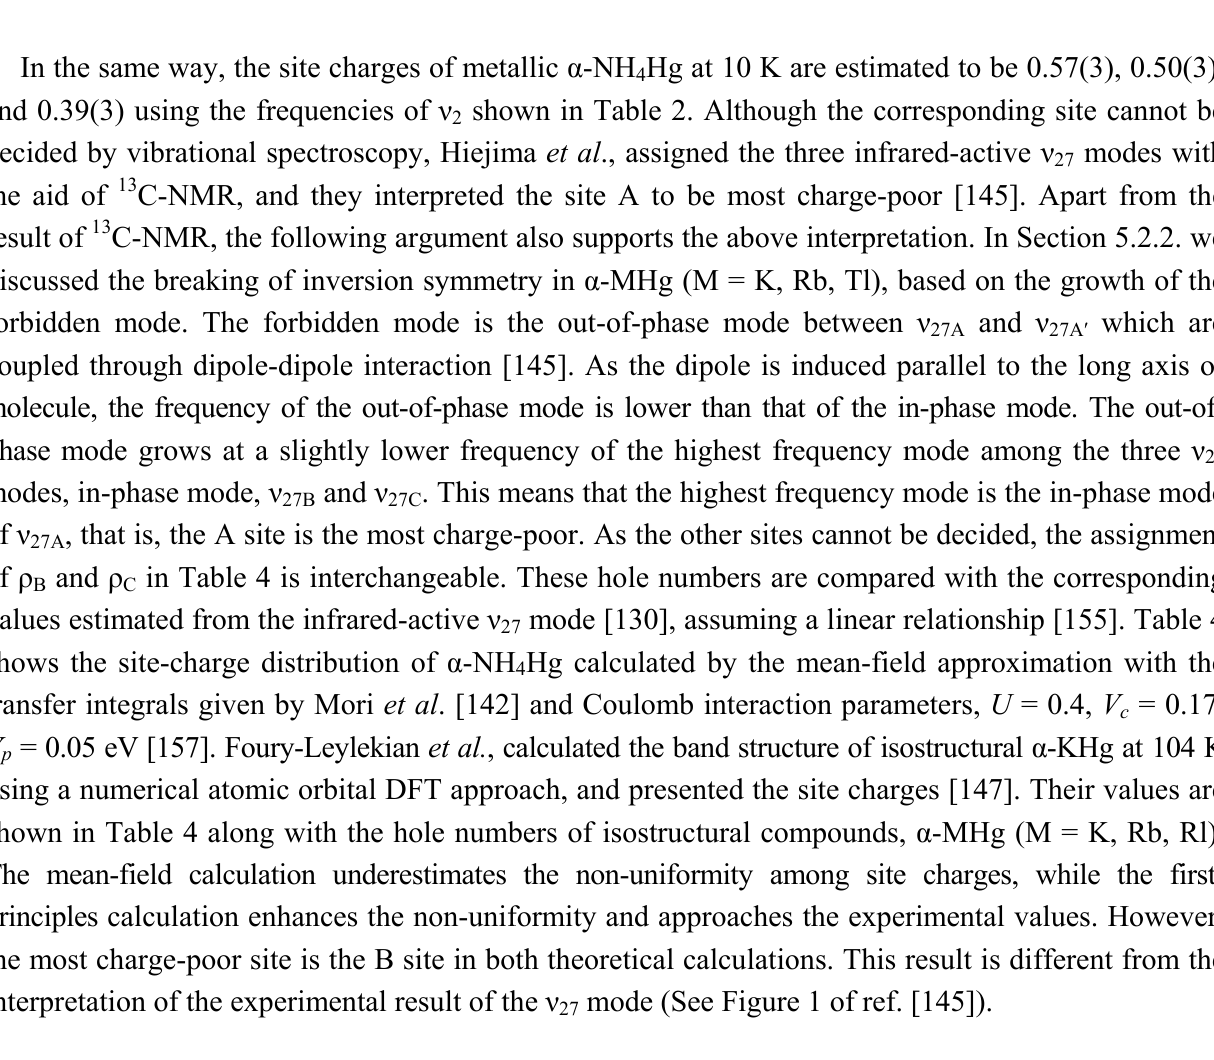
MHg(SCN) (M = NH , K, Rb, Tl). MF 2 4 4